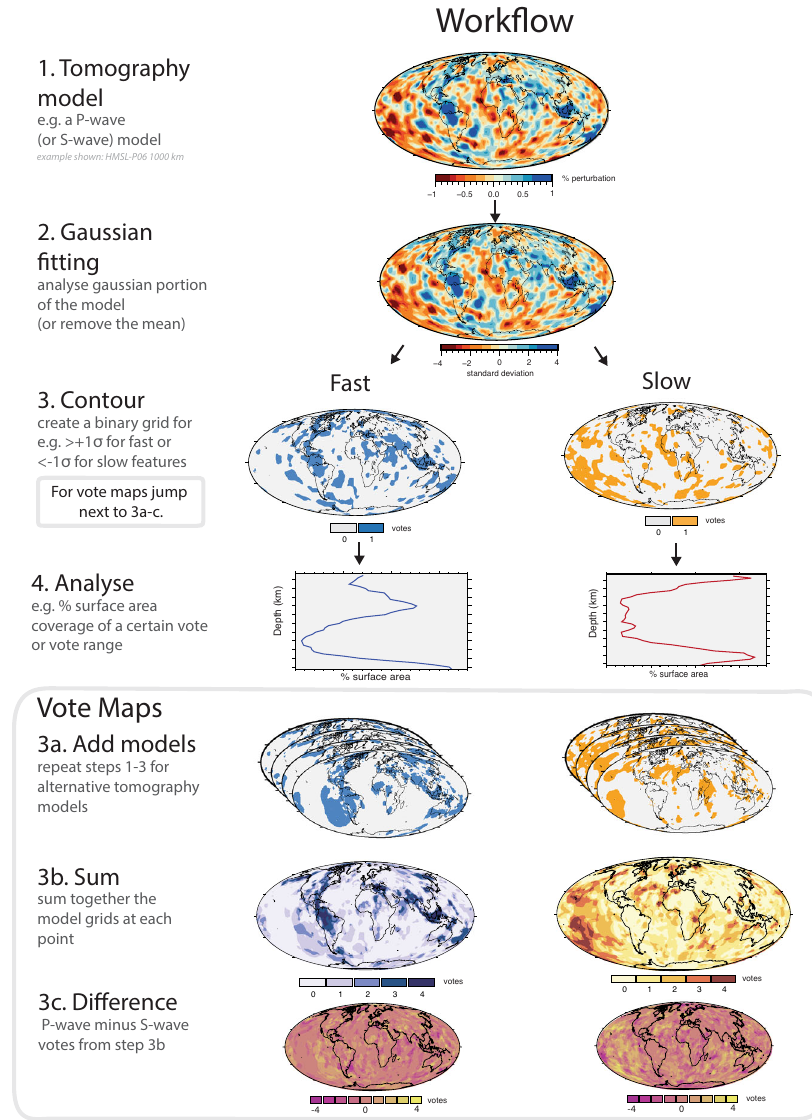
Fig. 3 Work fl ow used in this paper. Step 1: select tomography model. Step 2: a gaussian fi tting procedure is applied (see Methods). Step 3: a contour metric is chosen e.g. fast (> + 1 σ from the mean), and slow (< − 1 σ from the mean) and binary grids are created. Step 4: surface area coverage of the contour is extracted across the lower mantle. For the vote map methodology additional steps are applied between Steps 3 and 4. Step 3a: binary grids from additional tomography models are created as per Steps 1 – 3. Step 3b: at each grid point the constituent models (here 4 models) are summed. Step 3c: difference vote maps can be generated, for example by subtracting the S-wave votes from the P-wave